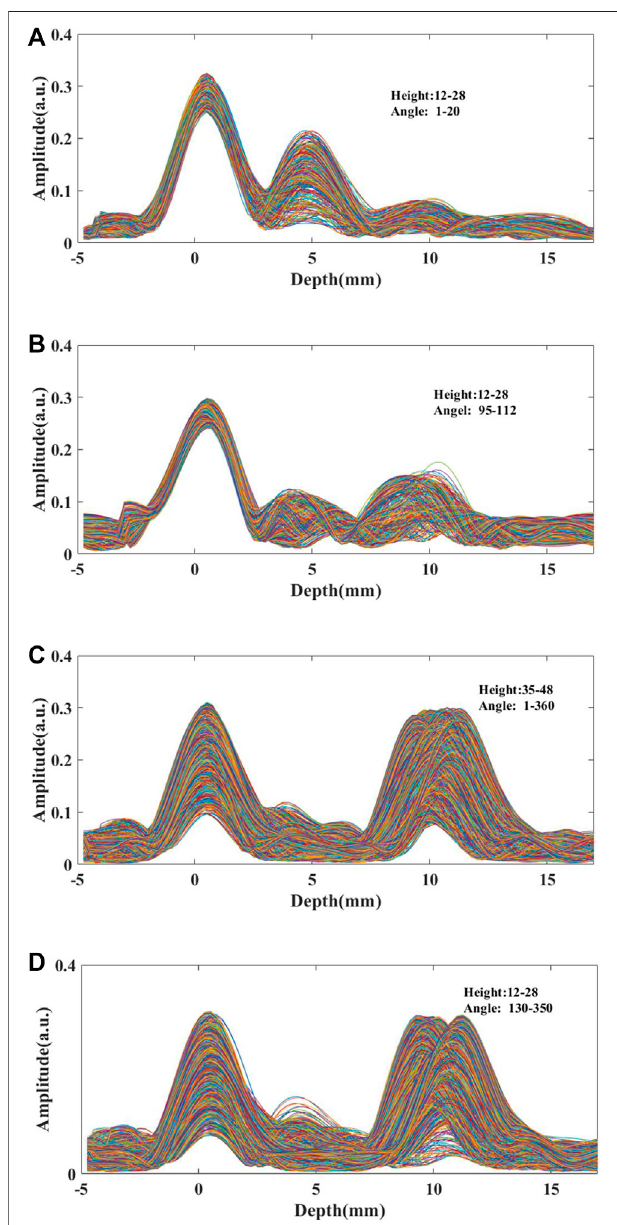
FIGURE 7 | A-scan signal characteristics in different height and angle ranges. (A) Height: 12 – 28 mm, angle: 1 – 20 ° ; (B) Height: 12 – 28 mm, angle: 95 – 112 ° ; (C) Height: 35 – 48 mm, angle: 1 – 360 ° ; (D) Height: 12 – 28 mm, angle: 130 – 350 °